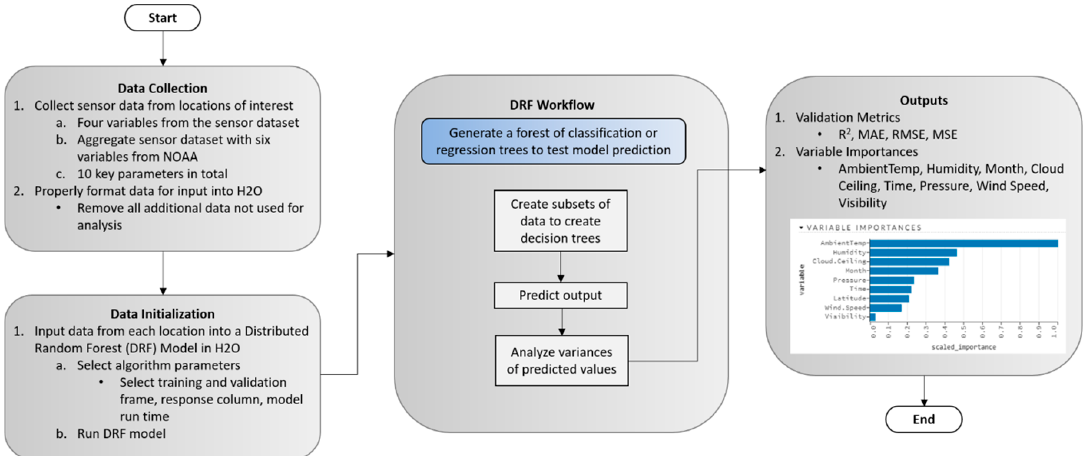
Figure 3. Nominal flowchart for distribution random forest (DRF) algorithm [46,47].